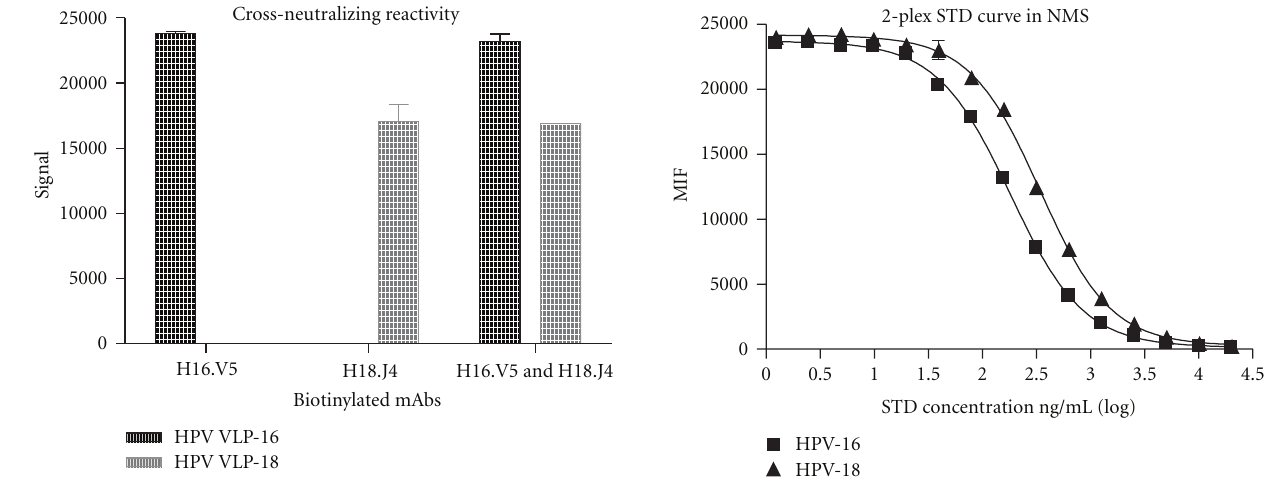
Figure 3: Cross-neutralizing reactivity investigation. Figure 4: 2-plex standard curve for the Luminex-based immunoas-